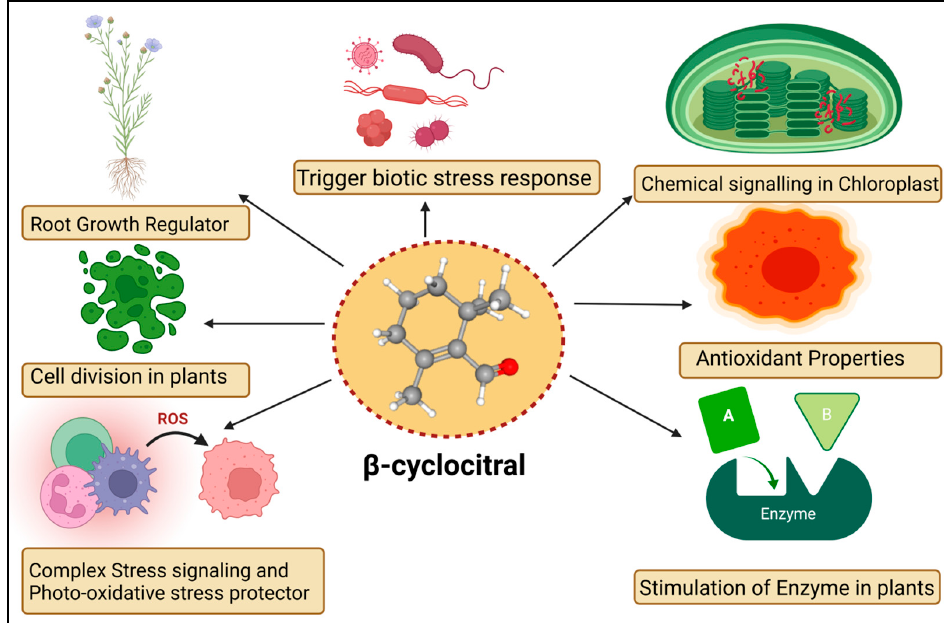
Figure 2. Diagrammatic sketch describing different functions of β -cyclocitral in plants. The mosses Hamatocaulis vernicosus and Sphagnum fexuosum compete for the release 6-trimethyl-1-cyclohexene-1-carboxylate, which is chemically linked to β CC. As a result,